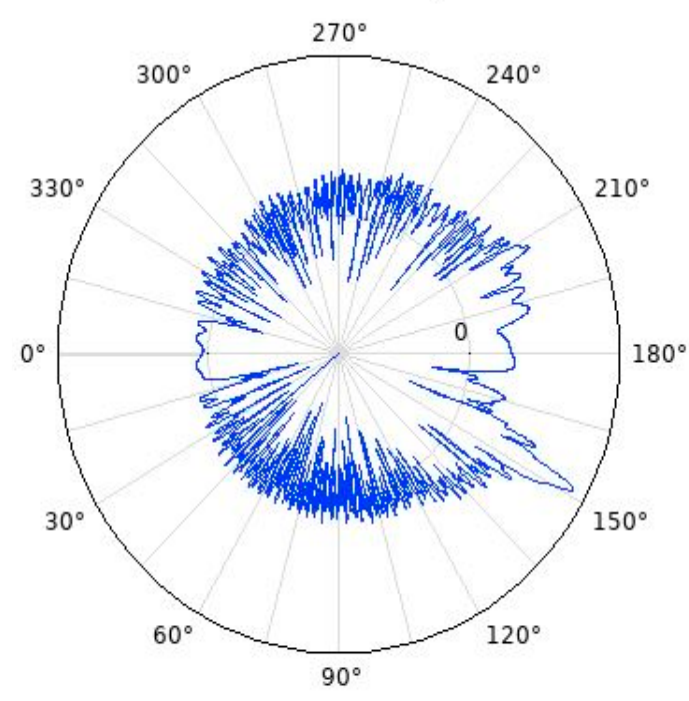
Figure 8. The polar plot of the sound pressure.